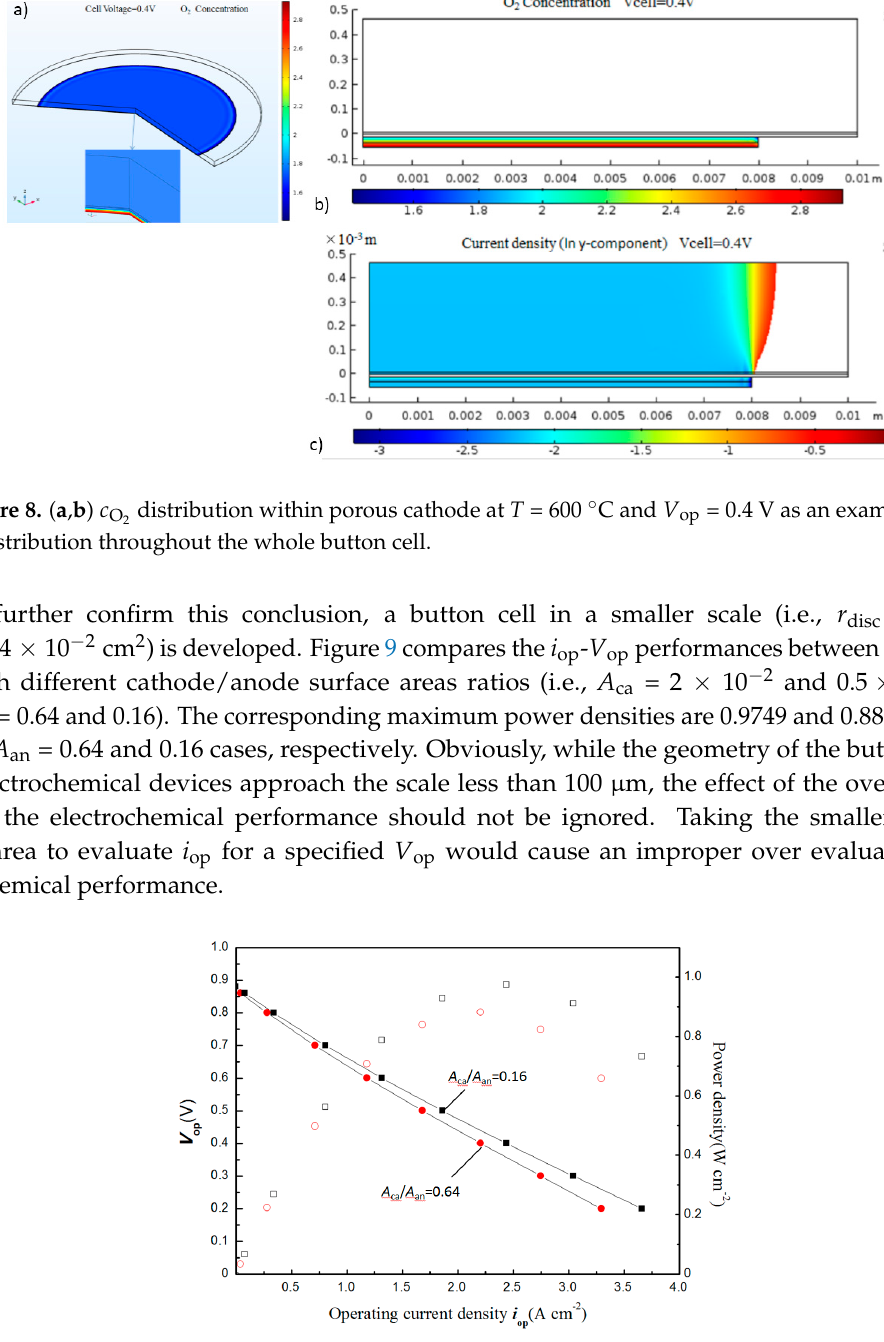
op = 0.4 V as an example;